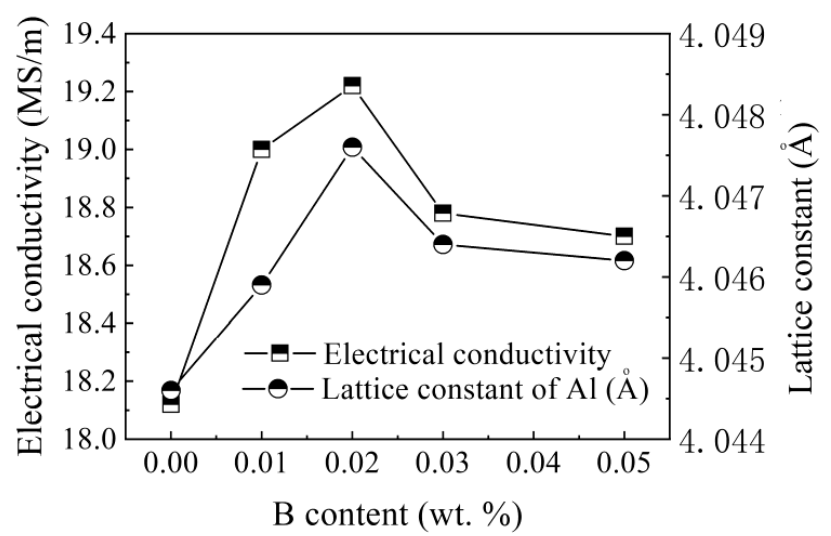
Figure 9. Relationship between B content and electrical conductivity, and lattice constants.